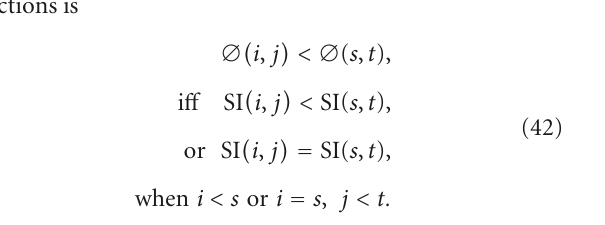
Table 1: Order of the structuring functions μ k